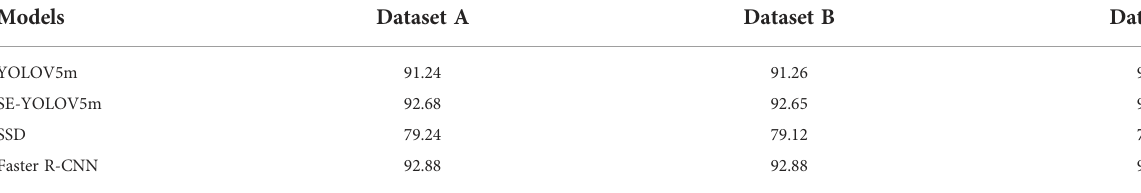
TABLE 3 Comparison of detection results under different weed rates.